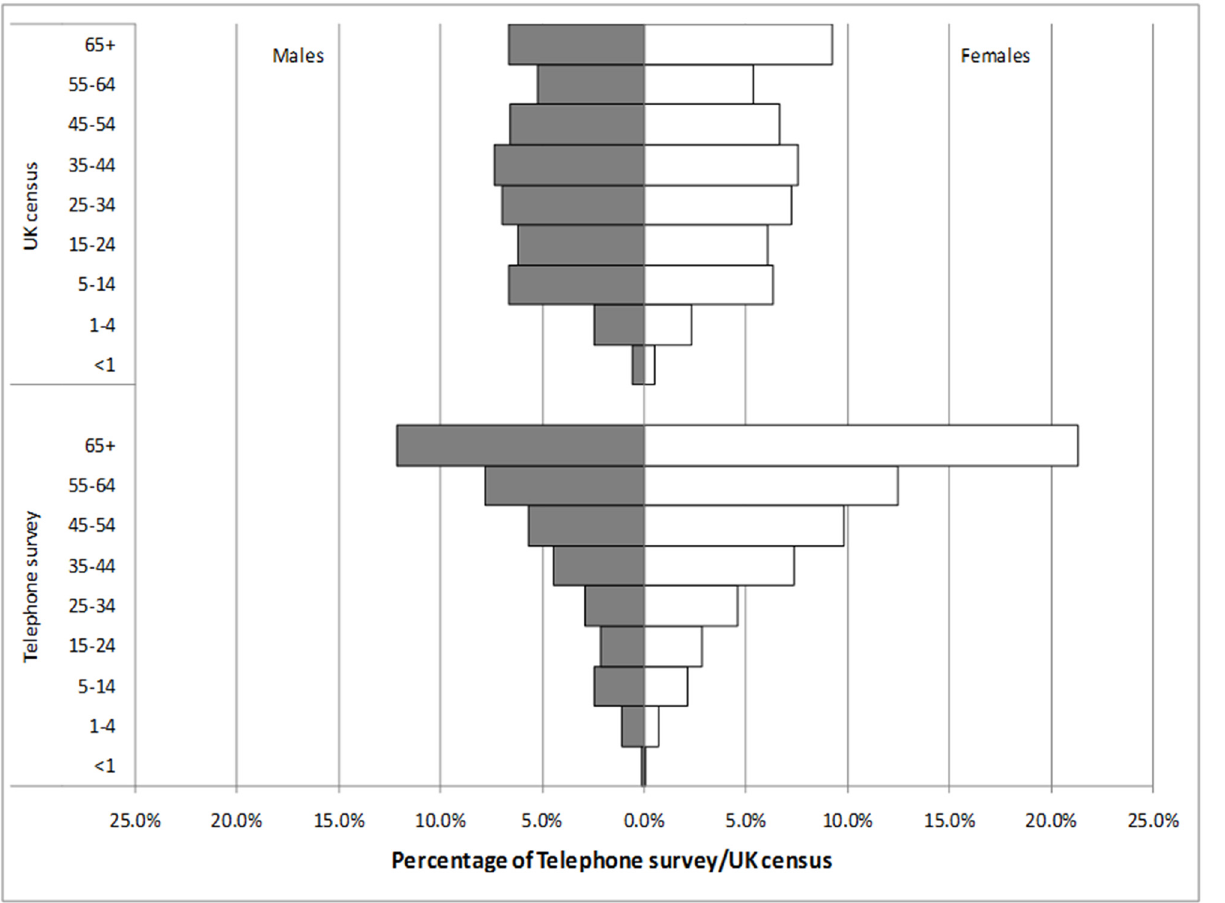
Fig 1. Age and sex structure of telephone survey participants compared with the UK census population.